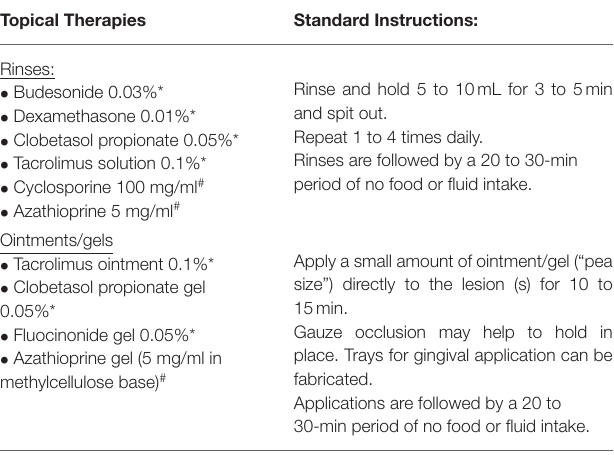
TABLE 1 | Topical therapies for oral mucosal cGVHD. Topical Therapies Standard